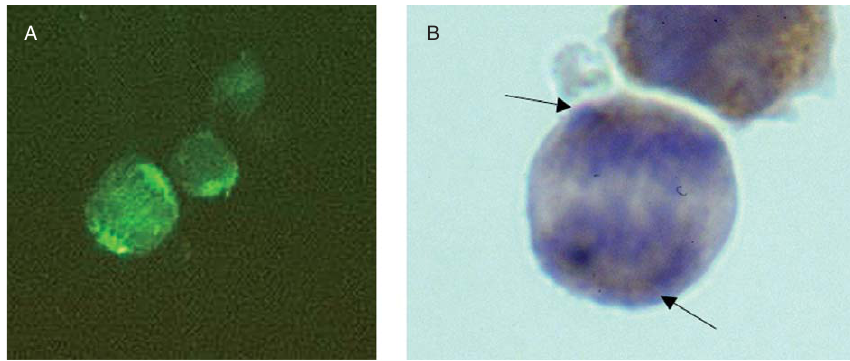
Fig. 4. ORC1 localization in anaphase cells. Cells A. Immunofluorescent staining of G2/M cells using anti-ORC1. B. G2/M cells stained with anti-ORC1 and peroxidase-conjugated second antibody and hematoxylin to visualize chromatin. Brown peroxidase staining is localized to the pericentriolar regions in anaphase cells